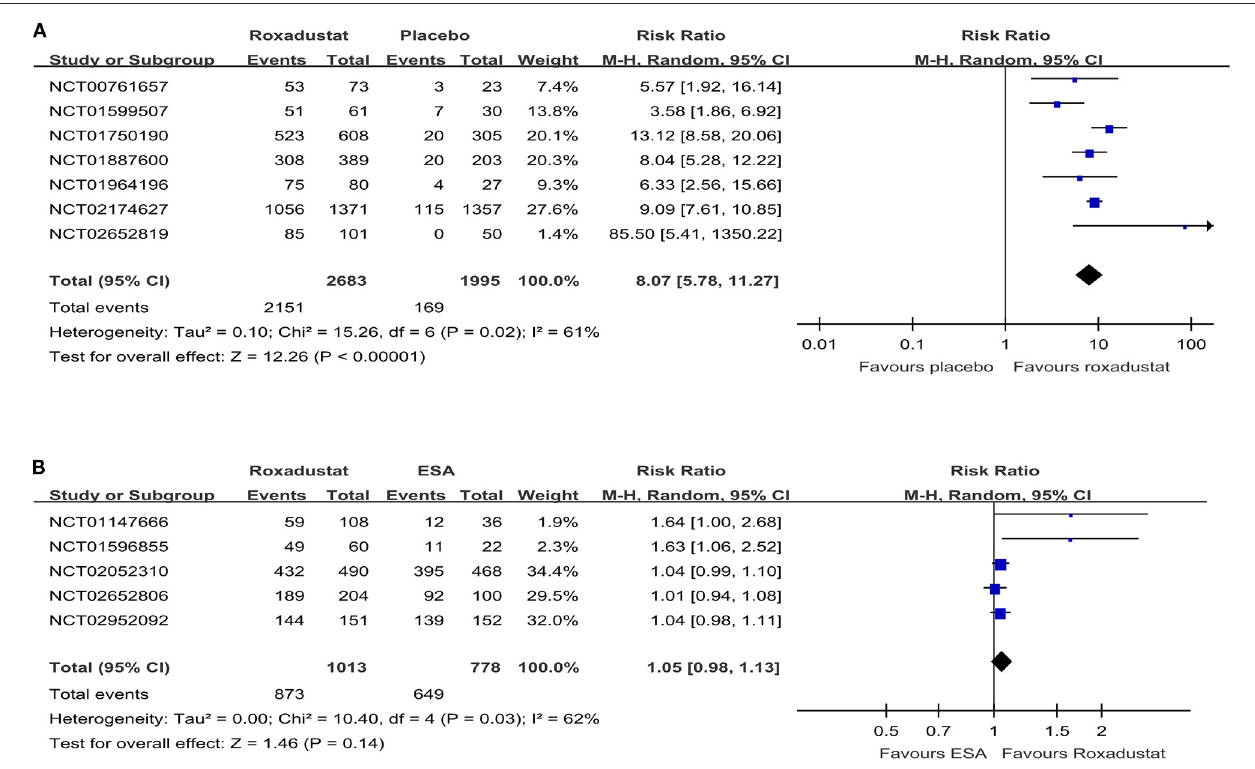
FIGURE 4 | Forest plot of the hemoglobin response rate. (A) Forest plot of the hemoglobin response rates of roxadustat and the placebo in NDD-CKD patients. (B) Forest plot of the hemoglobin response rates of roxadustat and ESA in DD-CKD patients. CKD, chronic kidney disease; CI, confidence interval; DD, dialysis-dependent; ESA, erythropoiesis-stimulating agents; NDD,